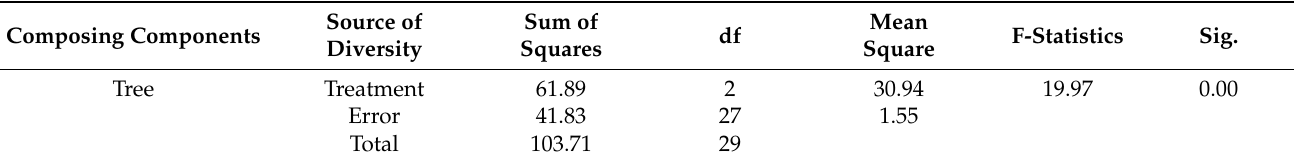
Table 8. One-way Anova analysis results for the average amounts of C stored in the litter under D. polyphylla stands for three age classes.